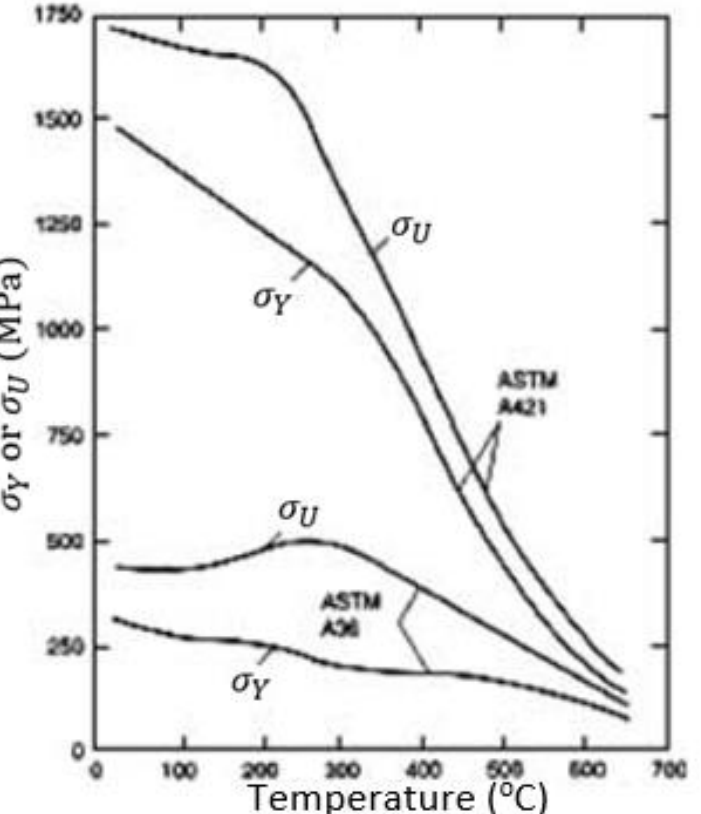
Figure 2. Tensile and yield strengths for structural steel (ASTM A 36) and prestressing steel (ASTM A 421) at high temperatures